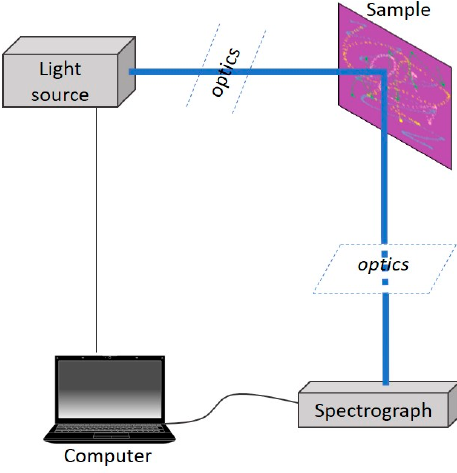
Figure 2. Typical simplified LIF set-up.